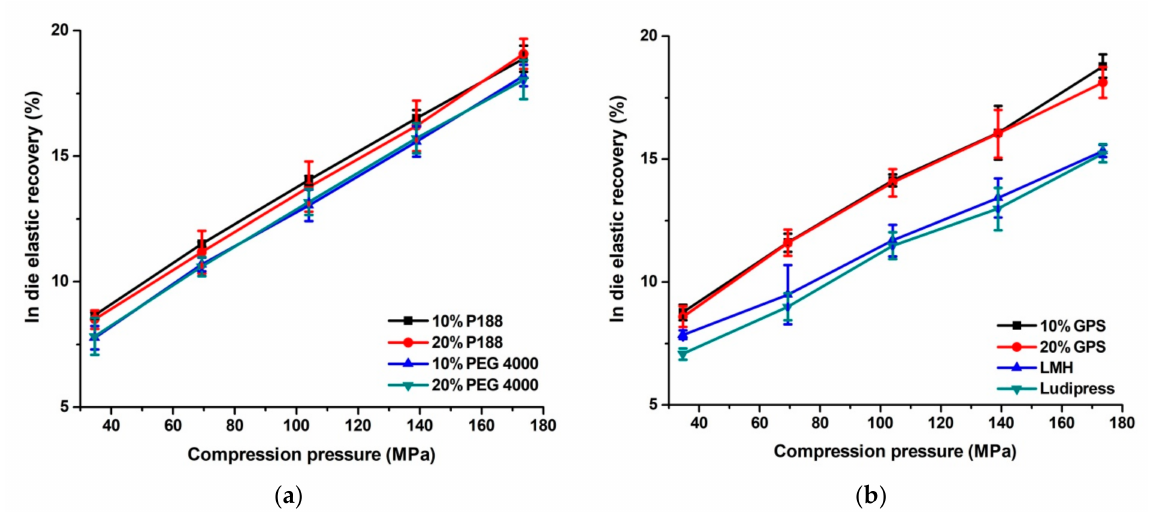
Figure 3. ( a , b ) In die elastic recovery for co-processed mixtures, LMH and Ludipress ®